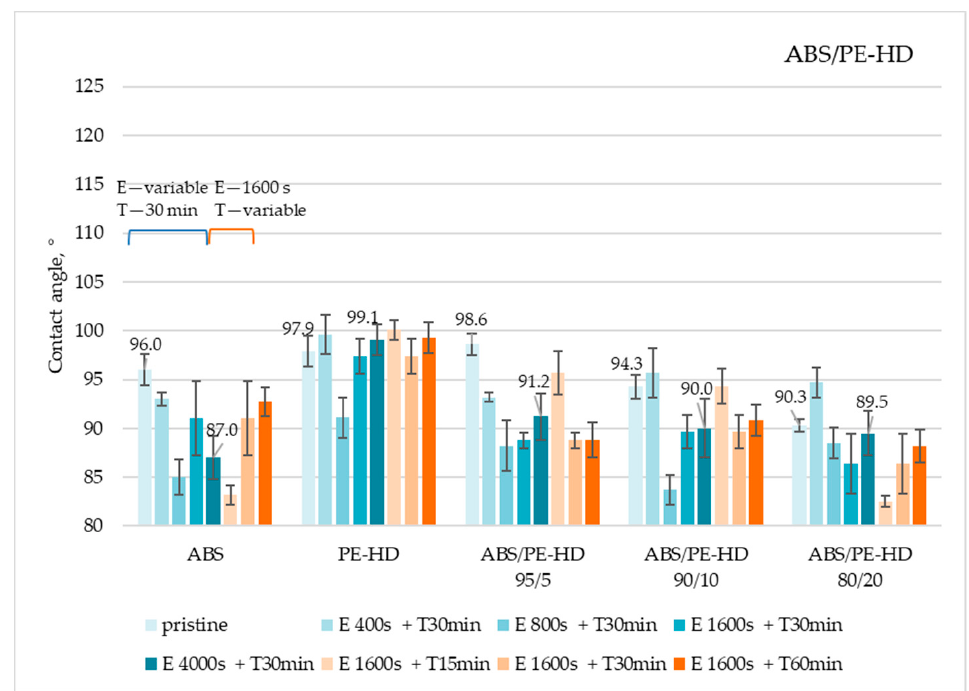
Figure 10. Water contact angles on ABS/PE-HD polymer blends treated under different etching and coating conditions (E—etching; T—CF x coating).